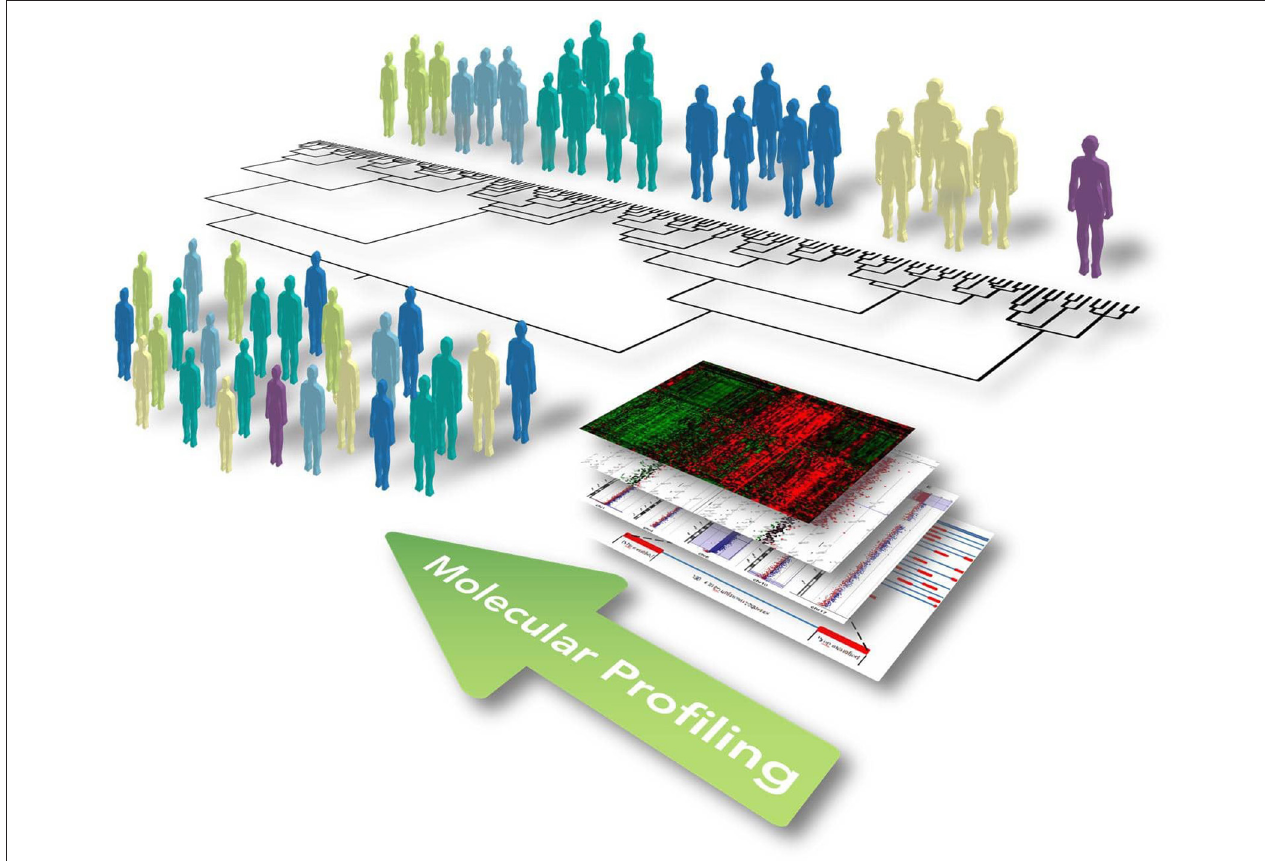
FIGURE 1 | Illustrative representation showing the concept of functional and integrated multi-omic approach for optimizing patient stratification and precision medicine. Widescreen genomic profiling of complex and multifactorial disorders, including ALS, has allowed us to better define disease mechanisms in different patients and identify multiple biomarkers on the gene, protein, and genomic scale. The omics profile of each individual, including the genome, transcriptome, proteome, and metabolome, should be eventually linked up with phenotypes obtained from clinical observations, medical images, and physiological signals. This information can be subsequently incorporated together using computational strategies to identify causal disease networks, stratify patients, and ultimately allow progression toward precision medicine encompassing new and selective therapeutics and preventative